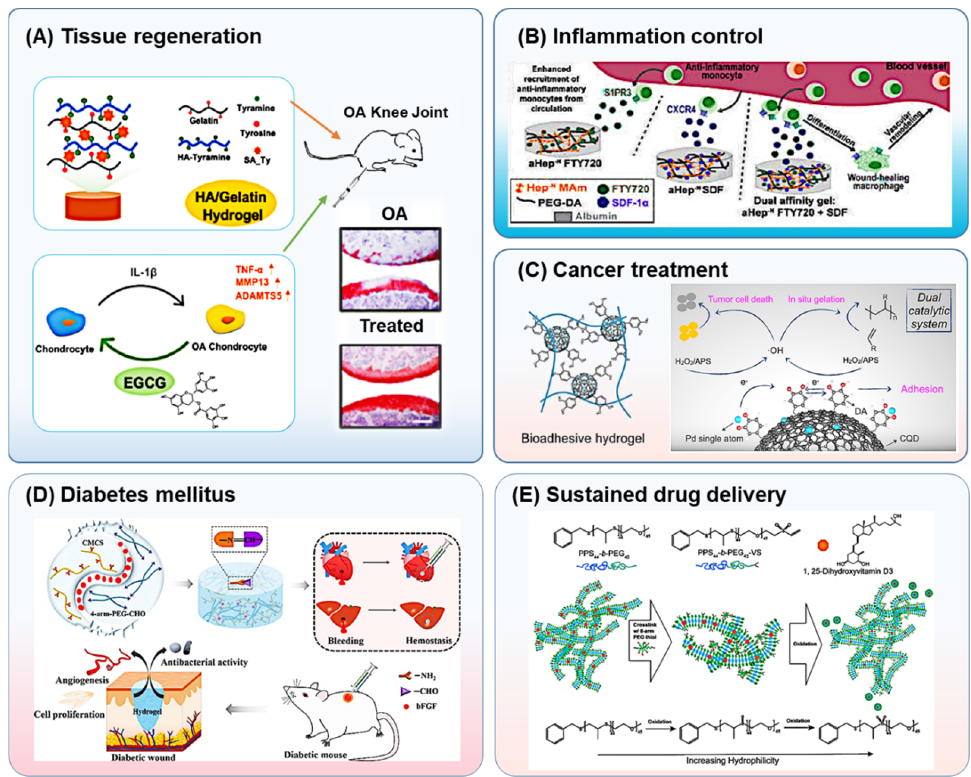
Figure 1. Different applications of immunomodulating hydrogels (IMHs) in disease treatments. ( A ) Tissue regeneration: Osteoarthritic (OA) cartilage repair. IMHs promote tissue regeneration and inflammatory cascade inhibition alongside drug delivery (redrawn from the original article [25]). ( B ) Inflammation control: Heparin-loaded hydrogels modulate inflammation and fibrosis incidence in medical implants (redrawn from the original article [20] ( C ) Cancer therapy: immunomodulating injectable hydrogel with carbon quantum dot for localized cancer immunotherapy (redrawn from the original article [31]. ( D ) Diabetes mellitus: Using chitosan-based hydrogel containing bFGF for diabetic wound healing. ( E ) Sustained release drug delivery: one type of vitamin D delivery. Hydrogel oxidation causes changing the hydrophobic/ hydrophilic ratio and a morphological transition in micelles’ structures resulting in release (Adapted with permission from [32]. Reproduced with permission from Elsevier ( A , C , D ), American Chemical Society ( B ), and Frontiers in Bioengineering and Biotechnology ( E ).